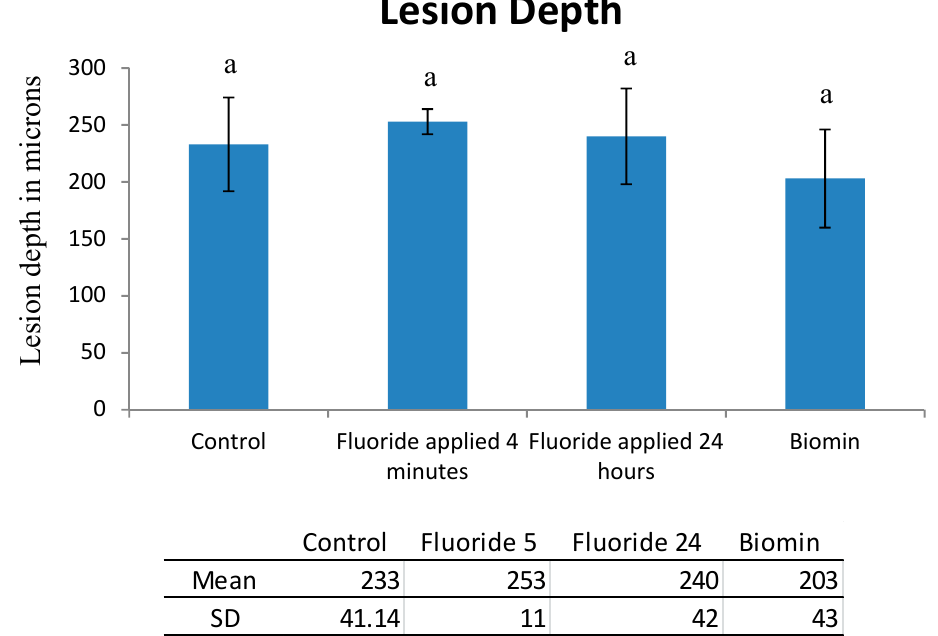
Figure 4. The results of Lesion Depth in μ m, presented by bar chart and Table, showing significant decrease in lesion depth for the Biomin group, compared to the remaining groups. Α = 0.05. Bars with same letters were not statistically significant α = 0.05.